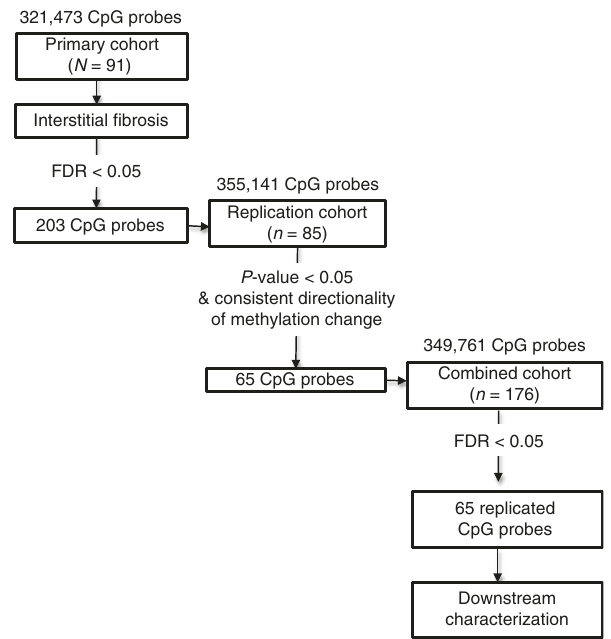
Fig. 2 Replication of the association between cytosine methylation and intersistial fi brosis Of the 203 probes signi fi cantly associated with interstitial fi brosis (FDR < 0.05) in the primary dataset, 174 probes were assessed in the replication data set. 29 probes were excluded due to poor data quality. In total 65 of 174 probes were associated with interstitial fi brosis in the replication data set ( p -value < 0.05). All probes had directional consistency of methylation change. The primary data set and replication data set were then combined to reassess for probes signi fi cantly associated with interstitial fi brosis (FDR < 0.05). All associations were determined by linear regression models adjusted for age, gender, race, diabetes, hypertension, batch, bisul fi te conversion, and degree of lymphocytic in fi ltrate on histology. Overall, 65 methylation